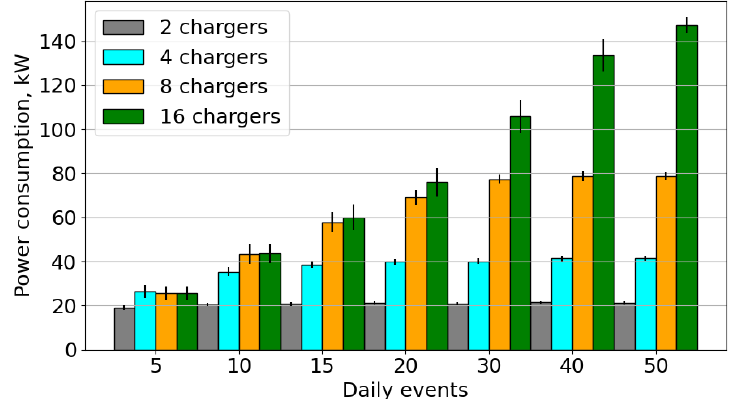
Figure 9. Mean values of maximum power consumption in 100 iterations for four sets of building chargers and various number of daily events. Vertical black bars illustrate the 95% confidence interval of the mean